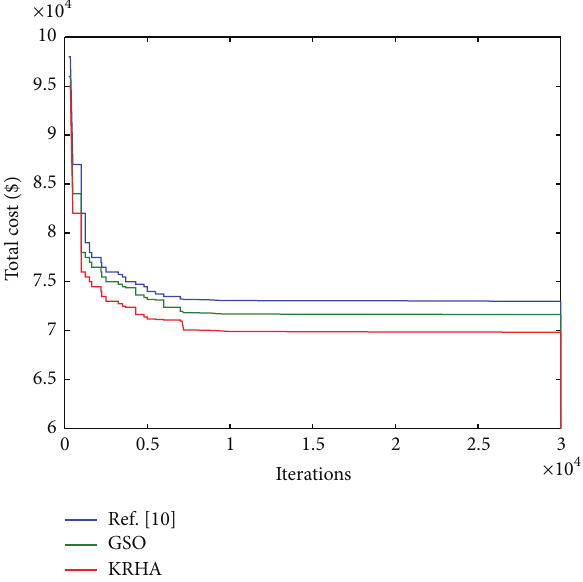
Figure 6: Variation of the optimum total cost for various CMR values.